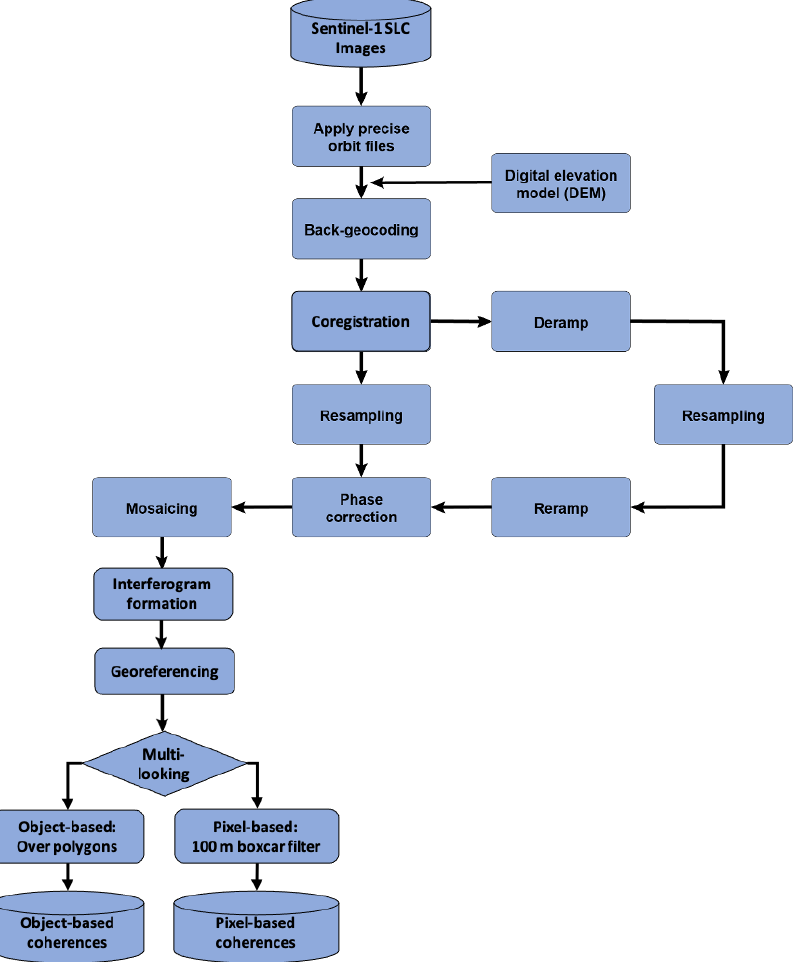
Figure 2. Processing chain for coherence feature extraction from the SLC Sentinel-1